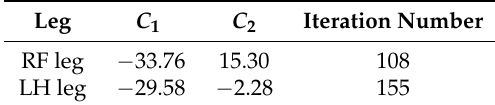
Table 5. The optimal parameters calculated by the Pattern Search method. Leg C